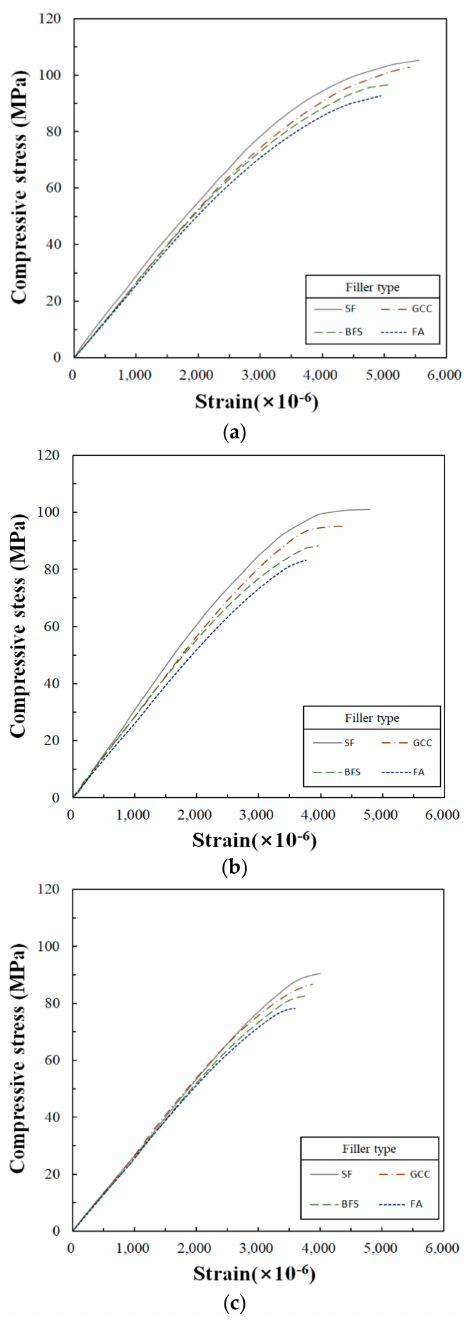
Figure 6. Compressive stress–strain curves by filler types: ( a ) SRA content is 0%; ( b ) SRA content is 10%; ( c ) SRA content is